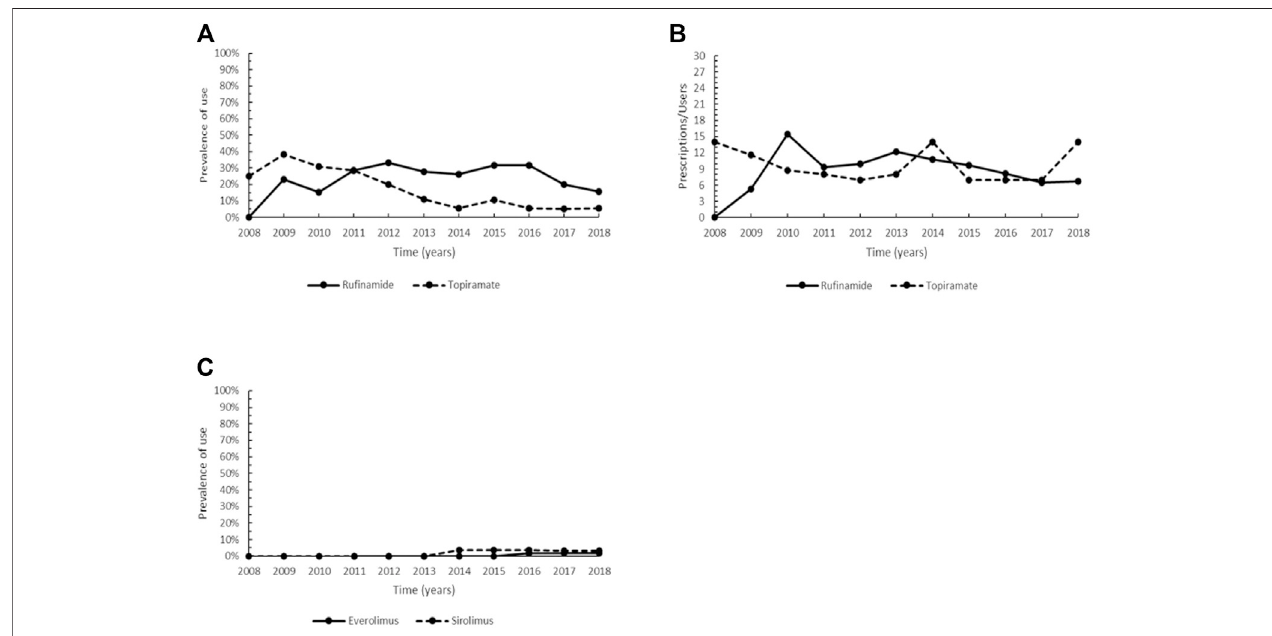
FIGURE 6 | Trend of the prevalence (graph (A) ) and intensity of use (graph (B) ) of the orphan drug ru fi namide and topiramate indicated for Lennox-Gastaut syndromeandtrendoftheprevalence(graph (C) )oftheorphandrugeverolimusandsirolimusindicatedfortuberoussclerosiscomplex.Prevalenceofuse:ratiobetween the number of cases with at least one prescription and the number of prevalent cases at the beginning of each year. Prescription/users: ratio between the number of prescriptions of each medication for the total number of patients with at least one dispensing per